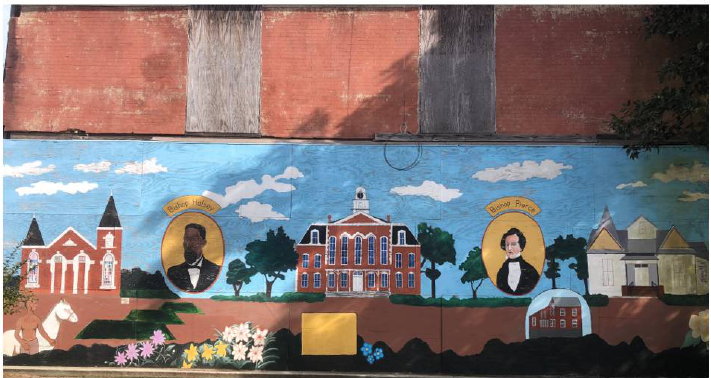
Figure 4. Mural of Bishops Lucious Holsey and George Foster Pierce in downtown Sparta. Photo- graph by Leo B. Gorman.